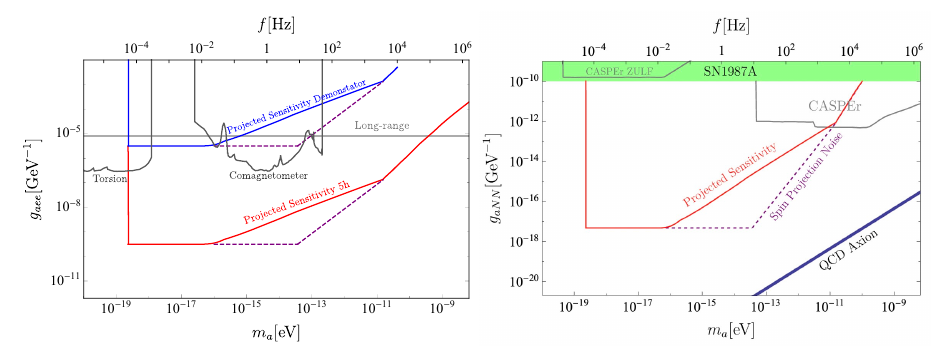
Figure 4. Projected sensitivity of the storage ring. Axion-electron coupling (left), with storage times of 1s (blue) and 5h (red), where we show current bounds from long-range interactions[37], torsion pendu- lum [38] as well as comagnetometer bounds [39]. Note that the red line approaches the astrophysical bounds [40]. The total scanning time for the blue line is 2h and for the red line 4 years. Axion- ∼ ∼ nucleon couplings (right) for a final stage with 5h storage time and a nuclear spin polarized xenon sample in the center of the ring. The projections of the CASPEr experiment are taken from [3,